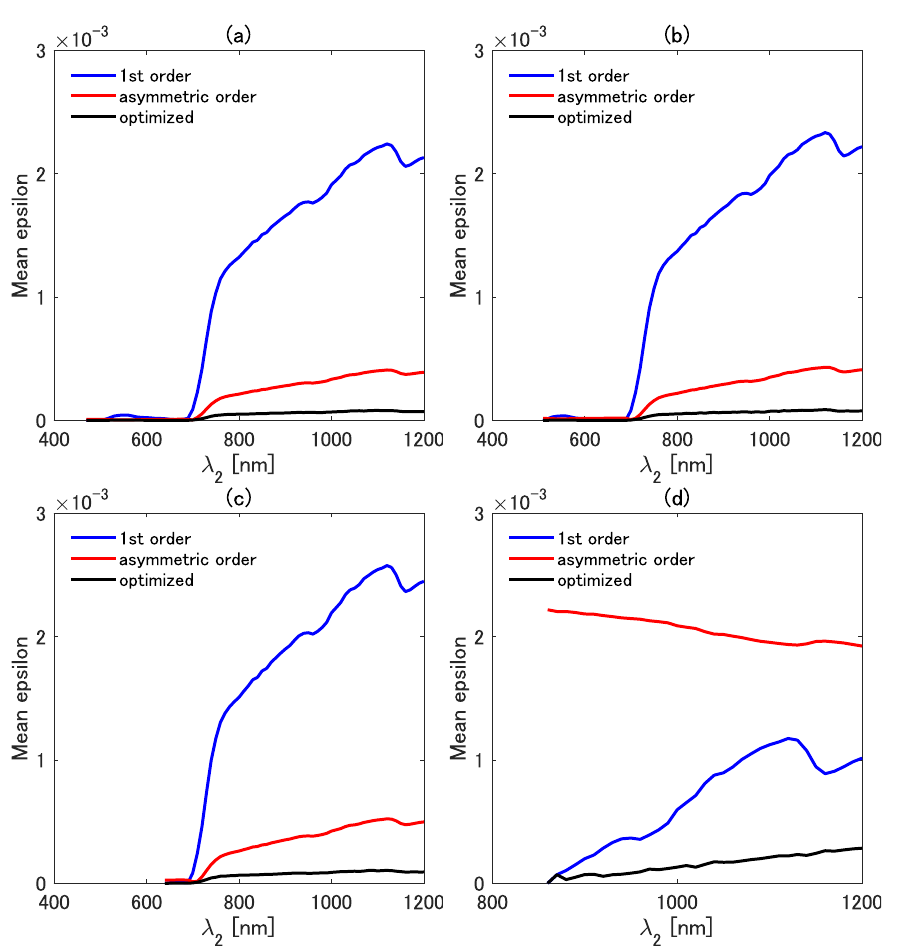
Figure 8. Comparisons of the mean epsilon among the first-order, the asymmetric-order, and the optimized asymmetric-order isolines as a function of λ 2 at four fixed values of λ 1 : ( a ) 470 nm, ( b ) 510 nm, ( c ) 640 nm, and ( d ) 860